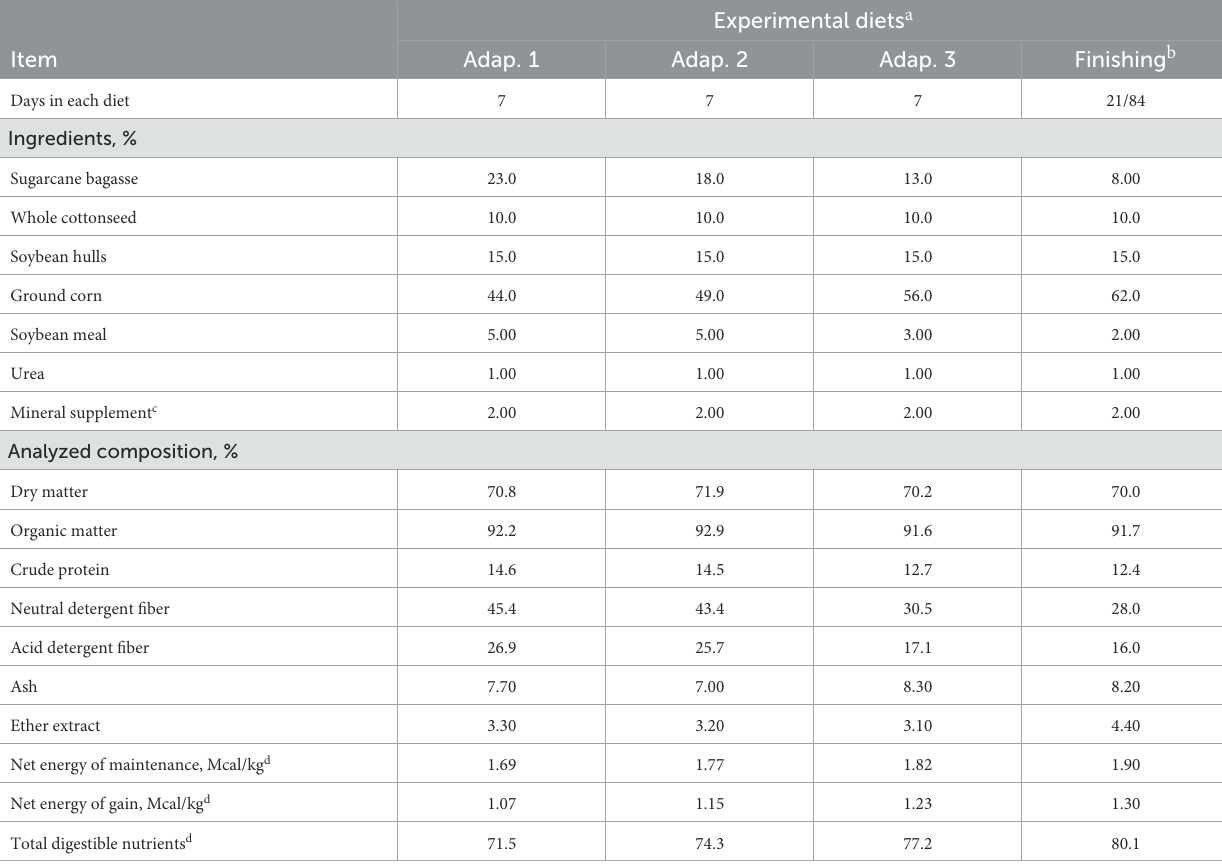
Experimental diets a